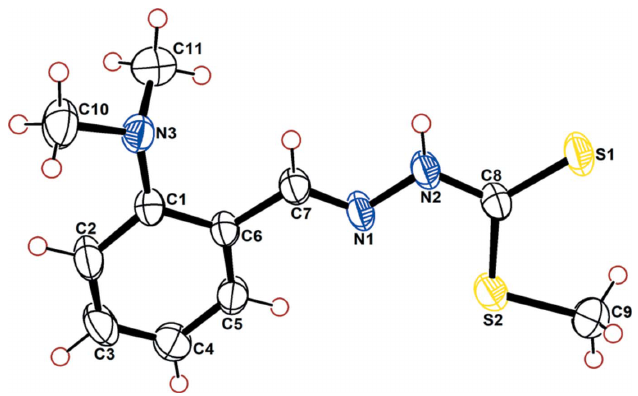
Figure 1 The molecular structure of the title compound, showing the atom labelling. Displacement ellipsoids are drawn at the 40% probability level.